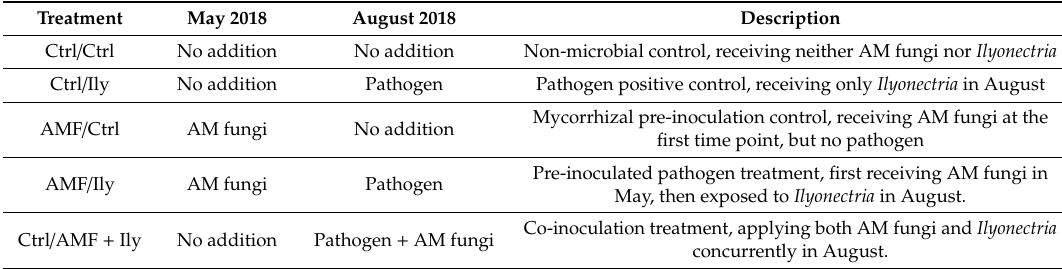
Table 1. Inoculation treatments applied to ‘Riparia gloire’ grapevine rootstocks. The fungal inoculants consisted of an arbuscular mycorrhizal (AM) fungus R. irregularis, and black foot pathogens Ilyonectria liriodendra. Treatment codes are as follows: Ctrl = no microbial addition, AMF = Arbuscular mycorrhizal fungi addition, Ily = Ilyonectria liriodendra addition. The slack “ / ” indicates the separation between two di ff erent treatment